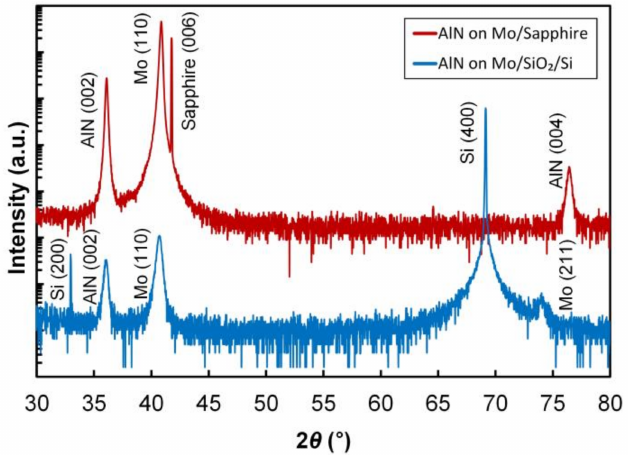
Figure 1. X-ray diffraction (XRD) 2 θ - ω scan patterns for the AlN thin films on the Mo elec- trode/sapphire and Mo electrode/SiO 2 /Si